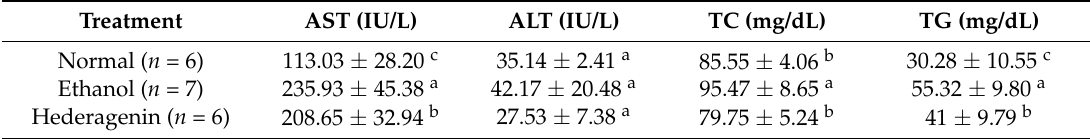
Table 2. Effects of hederagenin from Akebia quinata fruit on serum aspartate aminotransferase (AST), alanine aminotransferase (ALT), total cholesterol (TC), and triglyceride (TG) levels in ethanol-treated